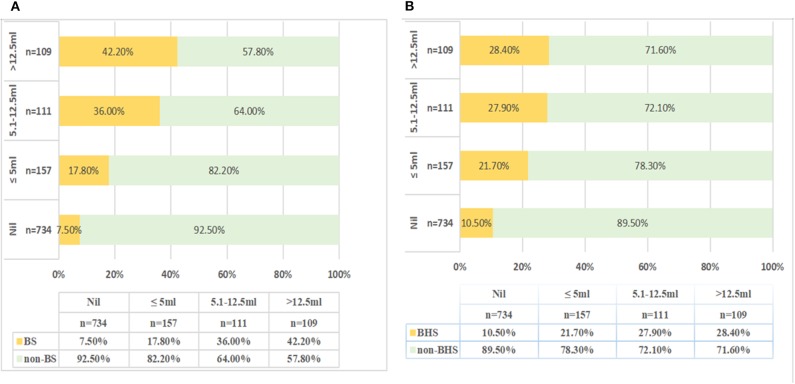
The proportions (%) of the BS (A) and BHS (B) in the four groups stratifying the extent of hematoma growth. The x-axis refers to the percentage of the BS or BHS (%). P < 0.001. BHS, black hole sign; BS, blend sign; Nil, no growth.